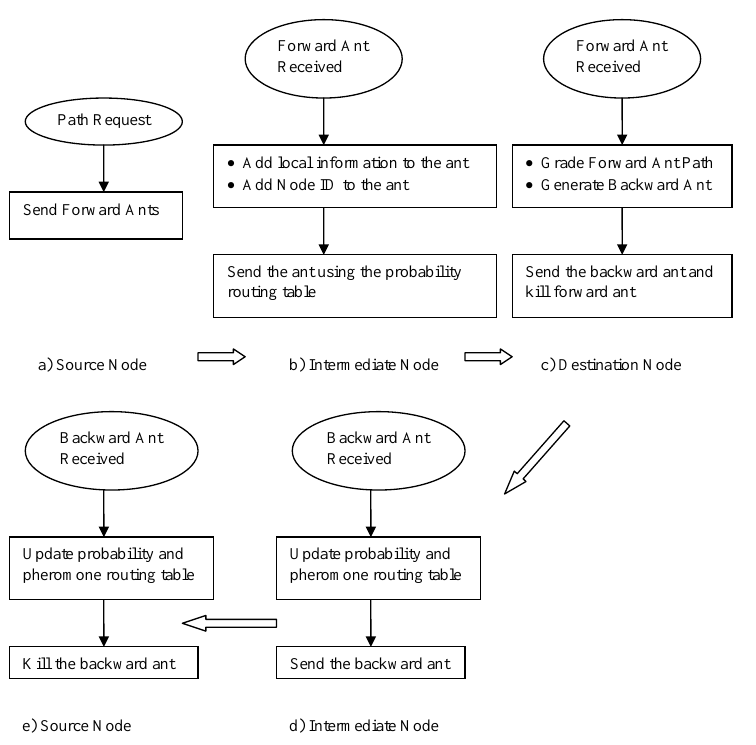
Fig 3 First Level functionality diagram of Ant colony based data